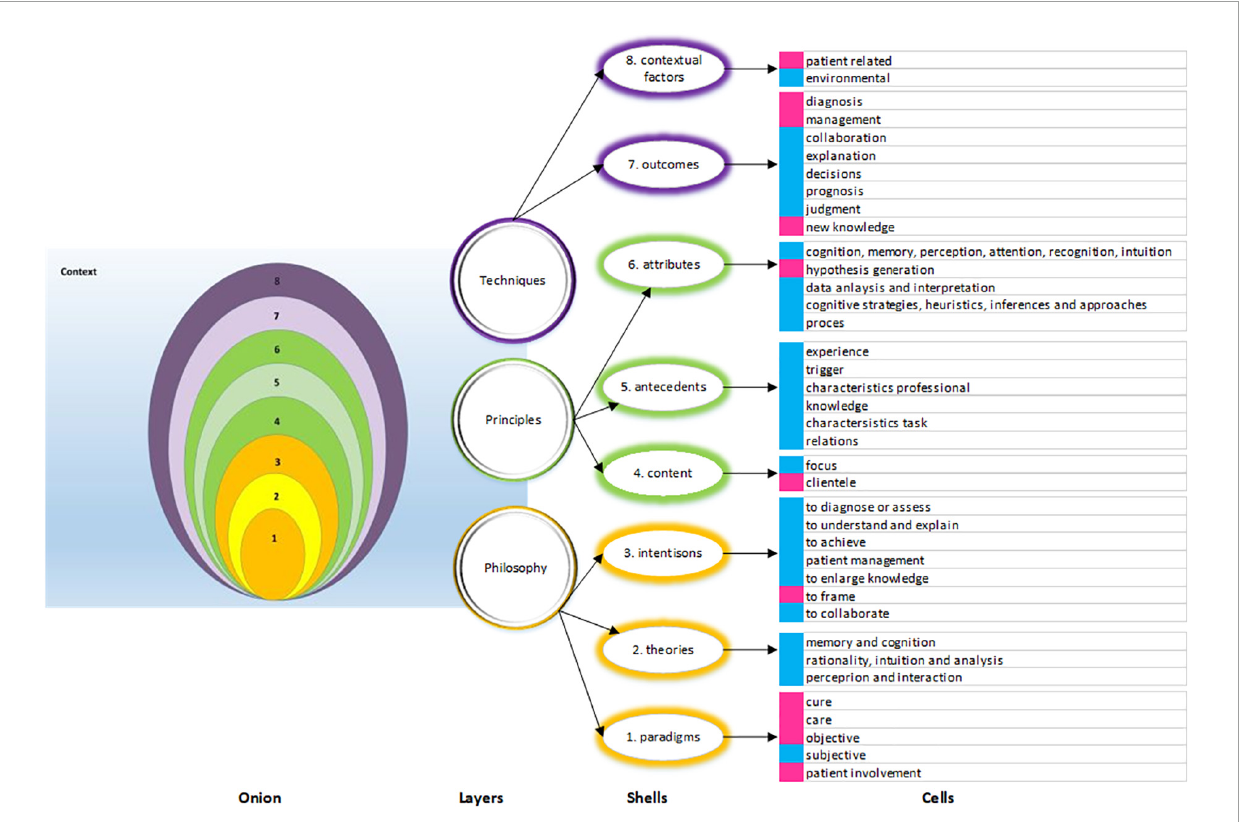
FIGURE2 Overview of commonalities and dissimilarities found in the layers, shells and cells. Three layers (purple, yellow, green), eight shells, made up of cells. The cells marked in blue represent commonalities, the cells marked in pink show dissimilarities in